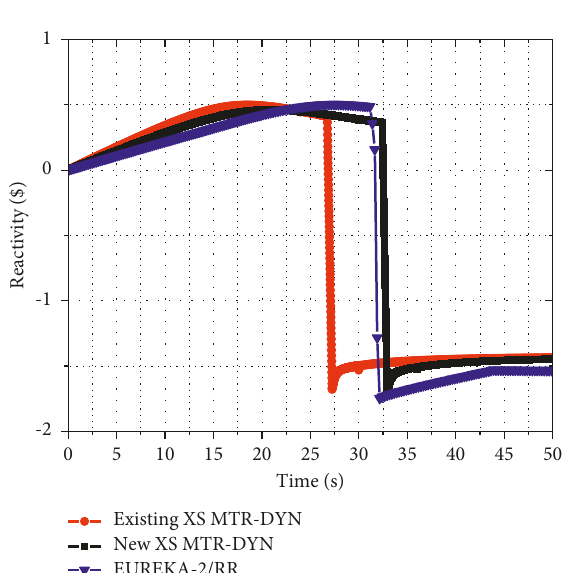
Figure 13: Reactivity inserted for RIA transient analysis within power range.